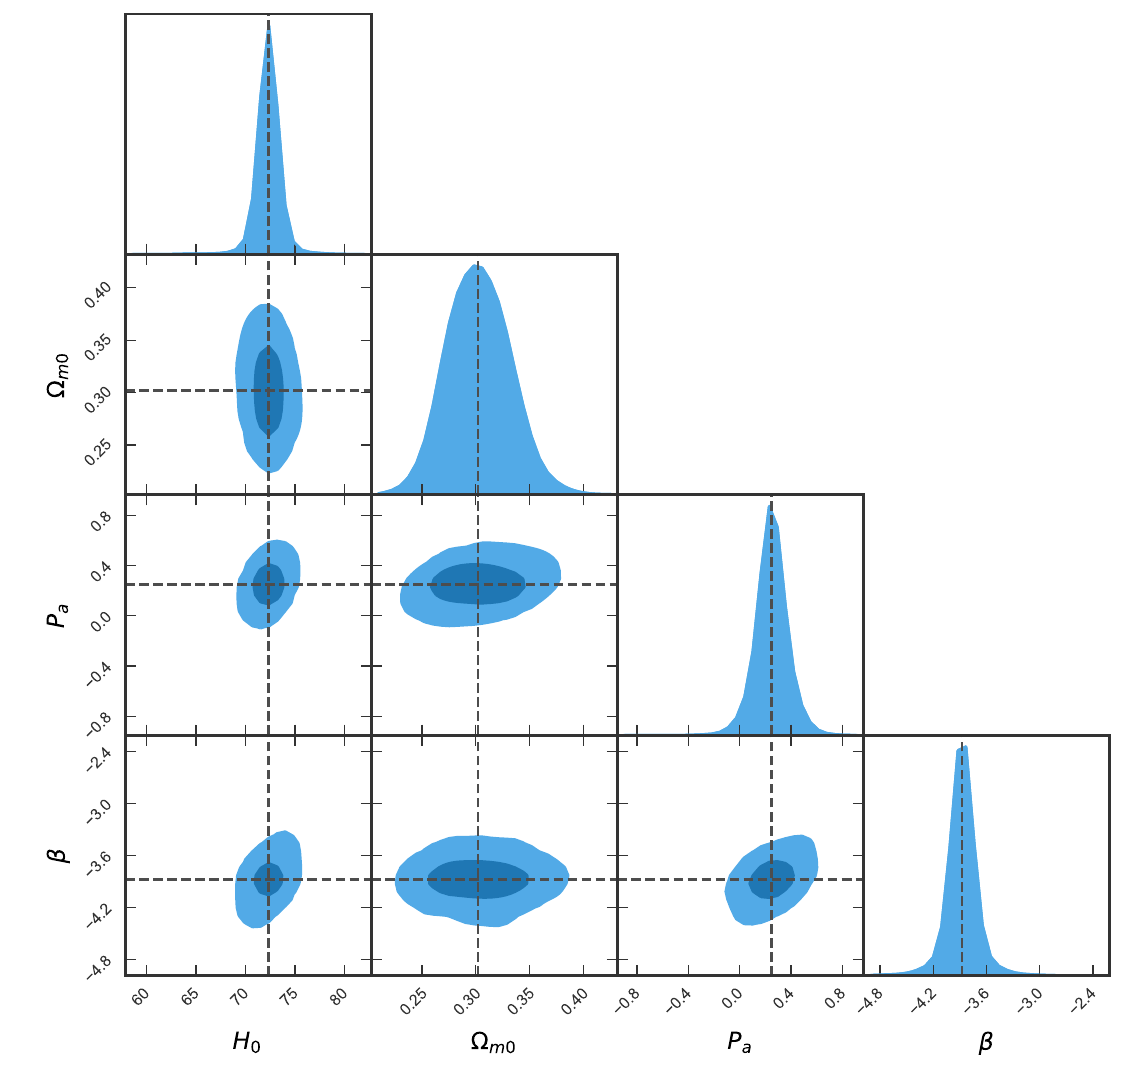
Fig. 1 The one-dimensional and two-dimensional marginalized probability distributions of the GP parameterization by using CC observations. The dark blue and light blue areas represent 1 σ and 2 σ errors, respectively